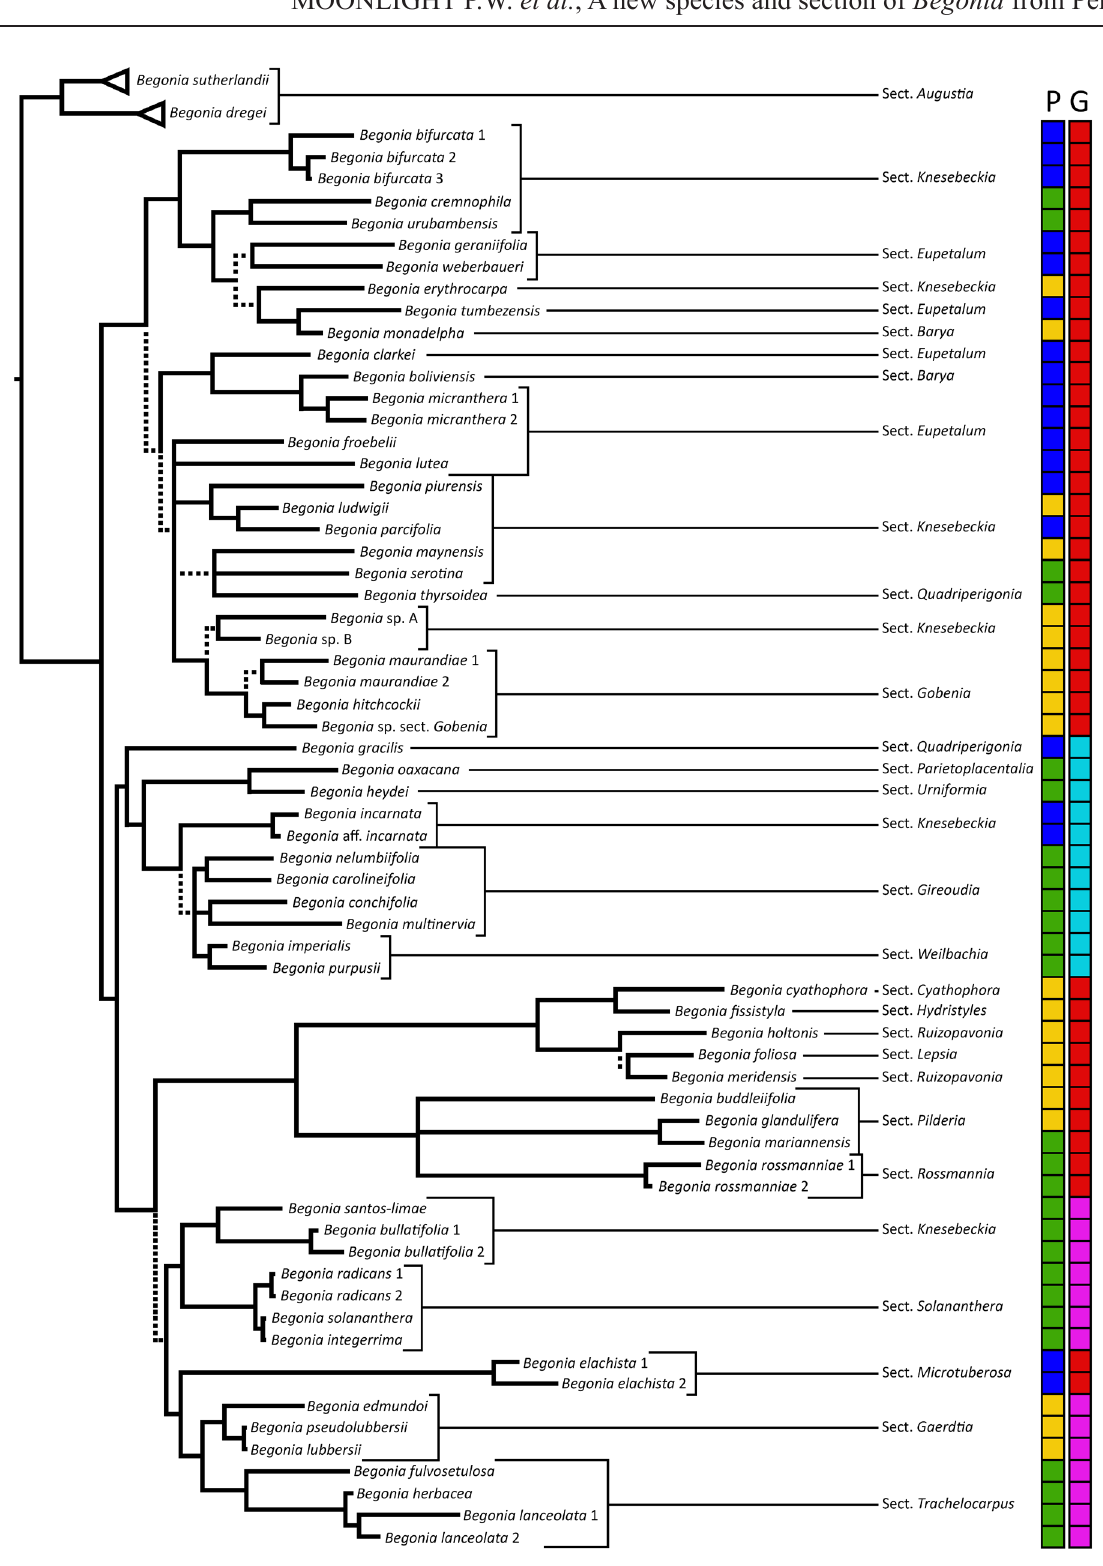
Fig 1. 50% majority rule consensus tree of MrBayes analysis of Neotropical Clade 2 (NC2) of Begonia . Dotted lines indicate posterior clade probabilities < 0.85. P, perenniation of species in NC2: blue, tuberous; green, rhizomatous; yellow, upright stems. G, geographic range of species in NC2: red, western South American; pink, eastern South America; light blue, Central America and